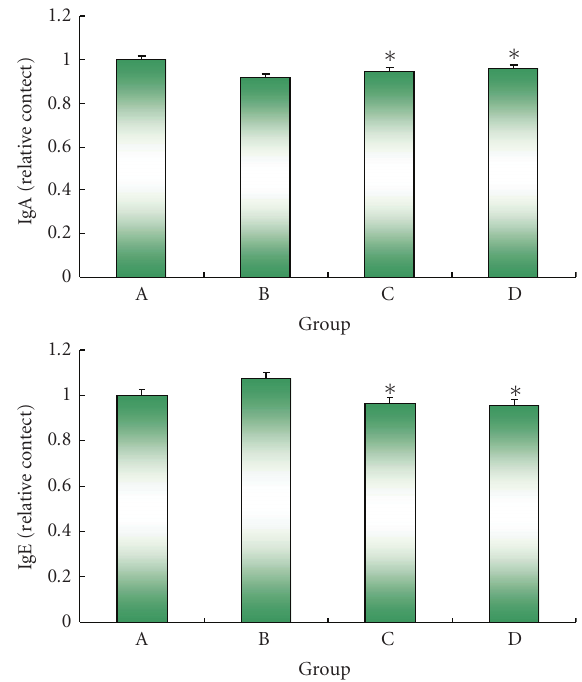
Figure 1: Changes of IgA and IgE production in serum of mice. (A) fed commercial diet, (B) fed commercial diet + induced colitis by DSS, (C) administrated IO, and (D) administrated IO + induced colitis by DSS ( n = 7 for each